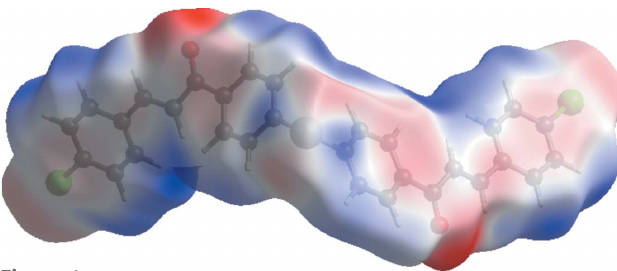
Figure 4 A view of the Hirshfeld surface plotted over the calculated electrostatic potential energy in the range (cid:5) 0.0489 to 0.0448 a.u.